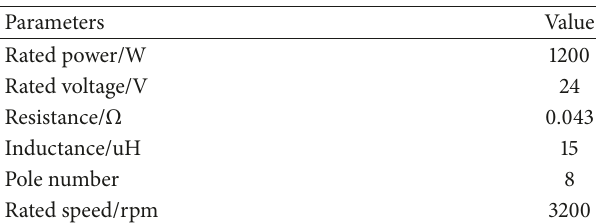
Table 1: The specifications of BLDC